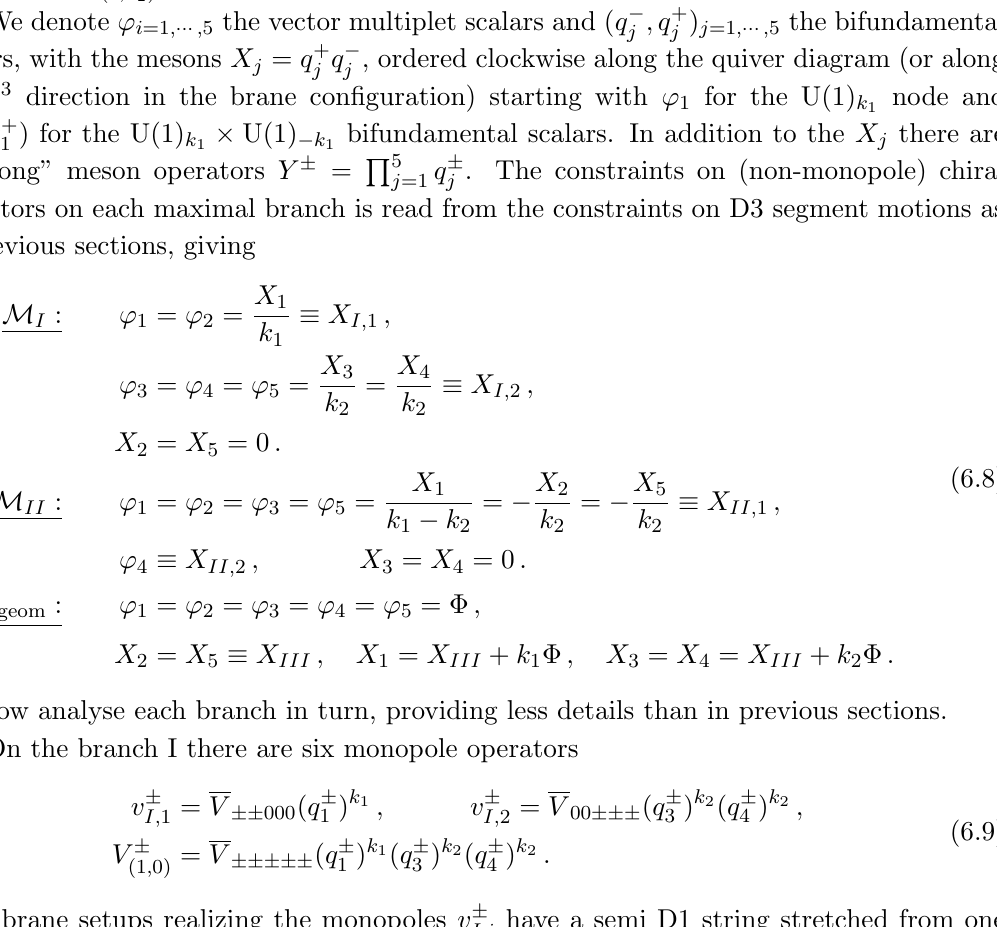
. (b) Brane setup with a I; 2